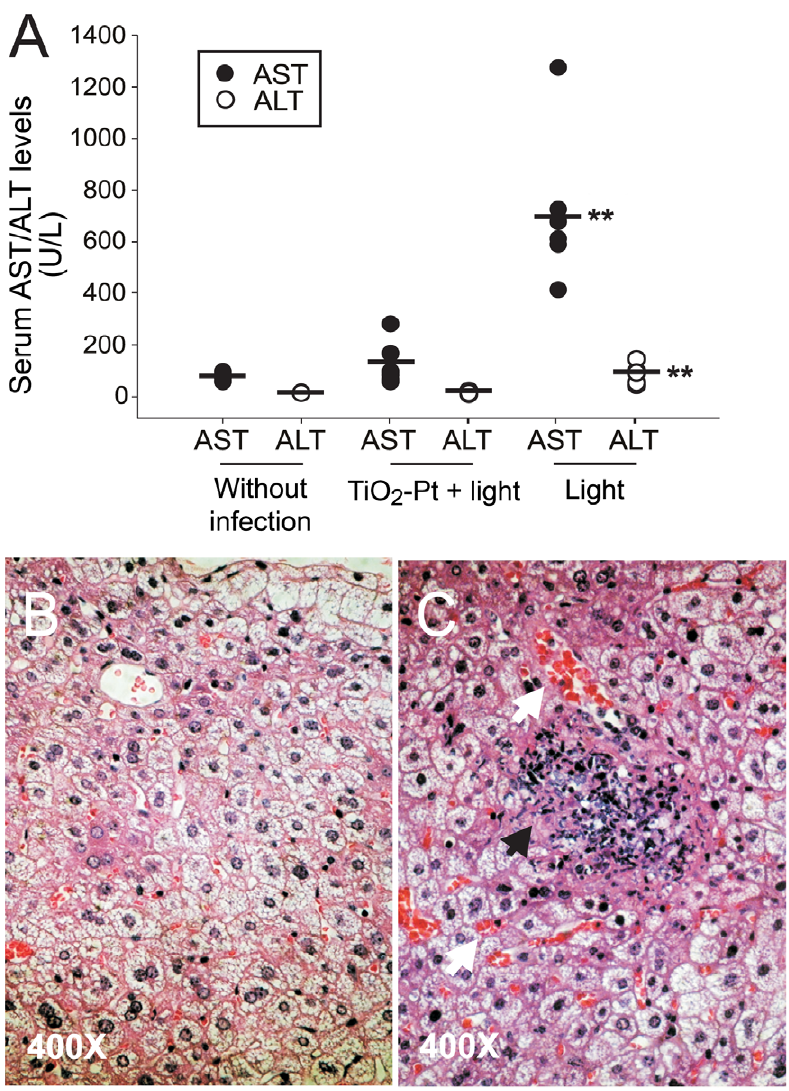
Figure 3. Liver damage in mice infected with B.pseudomallei . Twenty-four hours after inoculation with B. pseudomallei with or without photocatalysis, the serum AST/ALT levels of mice were examined. The means of the respective groups are indicated as horizontal bars; ** P , 0.01 and {{{ P , 0.001, compared with the TiO 2 -Pt + light photocatalyzed groups and without infection groups, respectively (A). The hematoxylin and eosin staining of liver sections from mice treated with B. pseudomallei with (B) or without (C) photocatalysis. White arrows: hemorrhage lesions; black arrow: cellular fragment and debris. n=6, three experiments with 2 replicates.